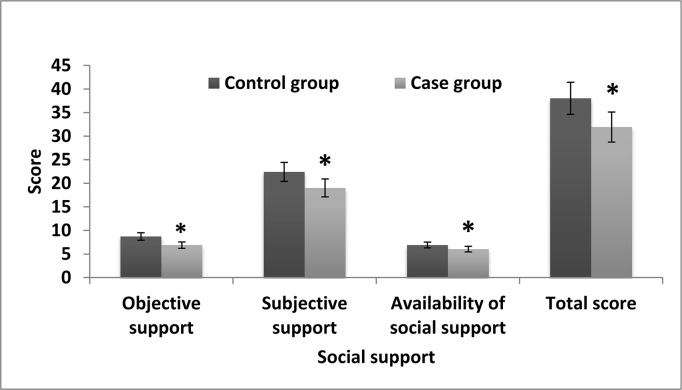
Comparison of Social Support Rating Scale scores between the case group of elderly patients with osteoporosis (n = 112) and control group (n = 102).Values are reported as mean ± SEM. *Significantly different from the control group (P < 0.01)